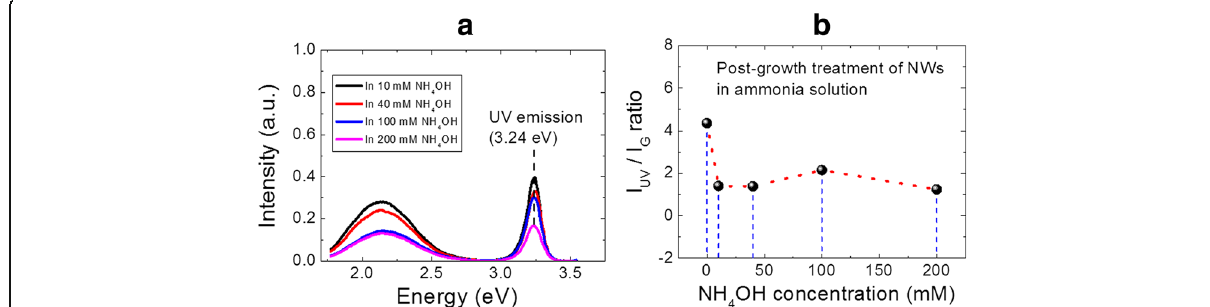
Fig. 4 a The PL spectra of the ZnO NWs treated in solutions with various ammonium hydroxide concentrations. b The intensity ratio of UV and green emission peaks as a function of NH 4 OH concentration, as extracted from